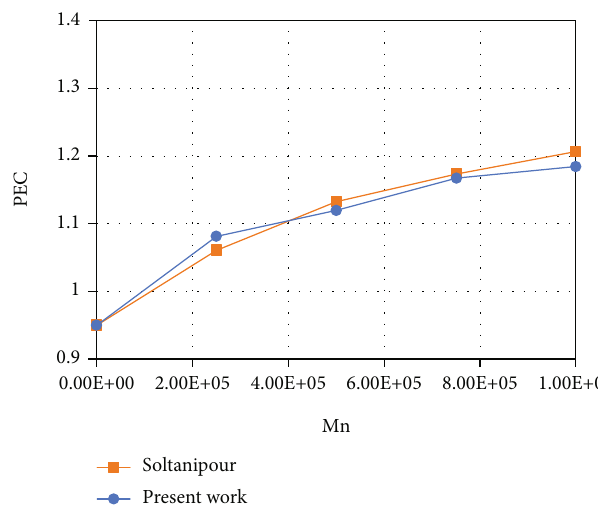
Figure 5: Check the validity of the results with Soltanipour and Pourfattah [23].